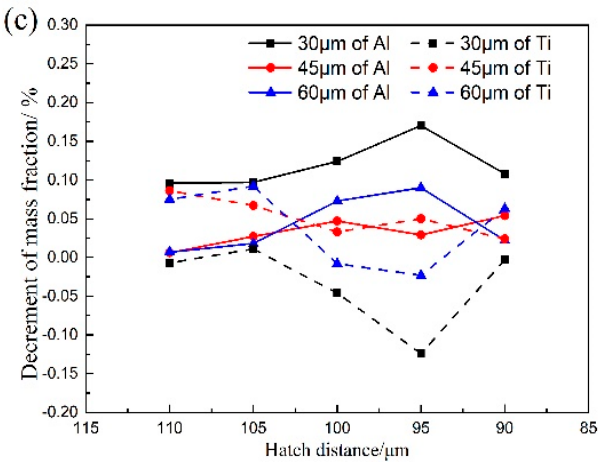
Figure 4. E ff ect of process parameters on the element vaporization of Al and Ti in alloy: ( a ) laser power; ( b ) scanning speed; ( c ) hatch distance.